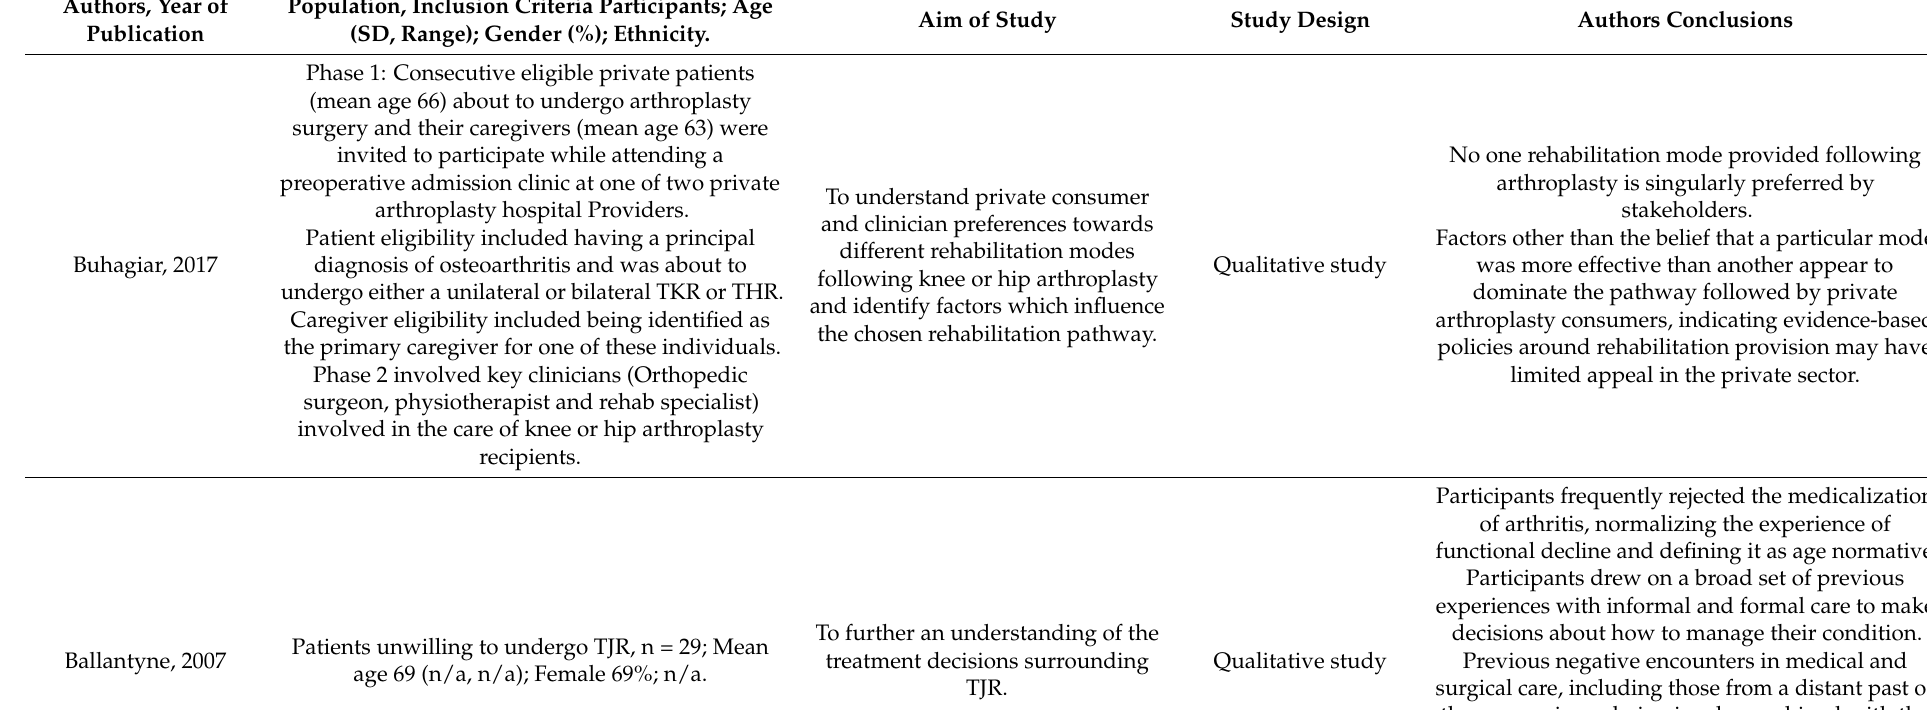
Table A7. Characteristics of the included manuscripts in the broad scope related to RQ1 and RQ2 (a) Characteristics of the included manuscripts in the broad scope related to